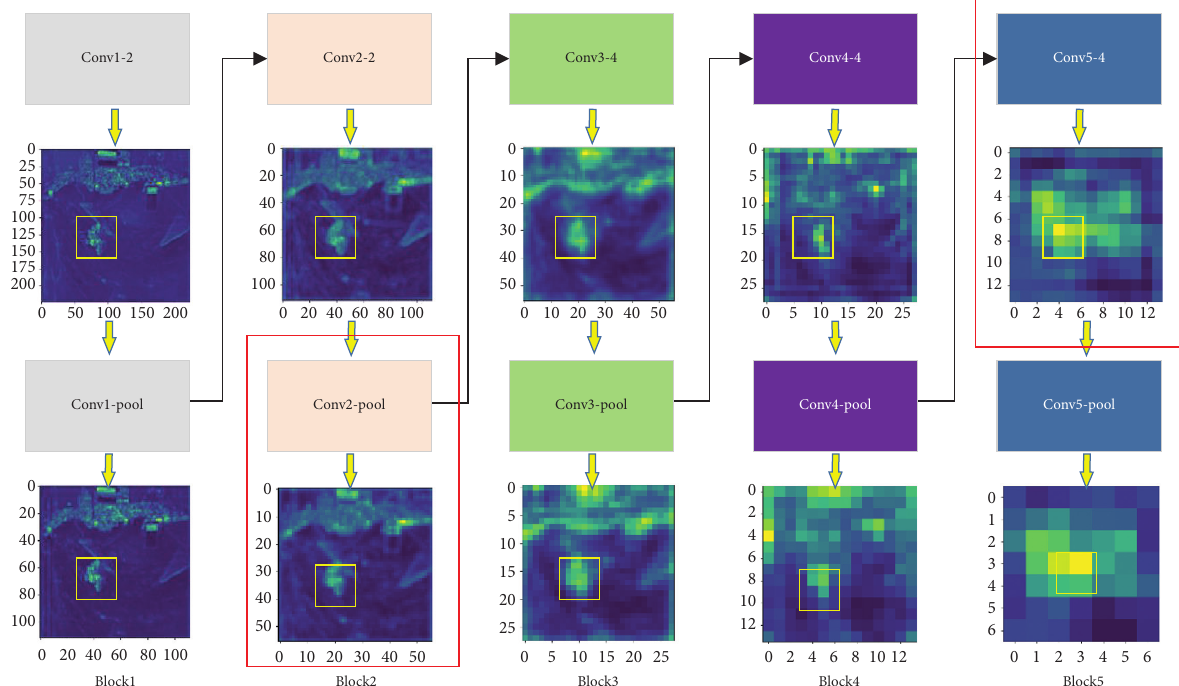
Figure 2: Visualization of convolutional layers on the challenging MotorRolling sequence. The yellow bounding boxes indicate the tracking results by our method. The red bounding boxes indicate the feature layer selected by our algorithm. Although the target is seriously deformed, the target position can still be identified by using the output features of the Conv5-4 layer. Compared with the features of the Conv5-pool layer, the resolution is too low to locate the accurate target position.